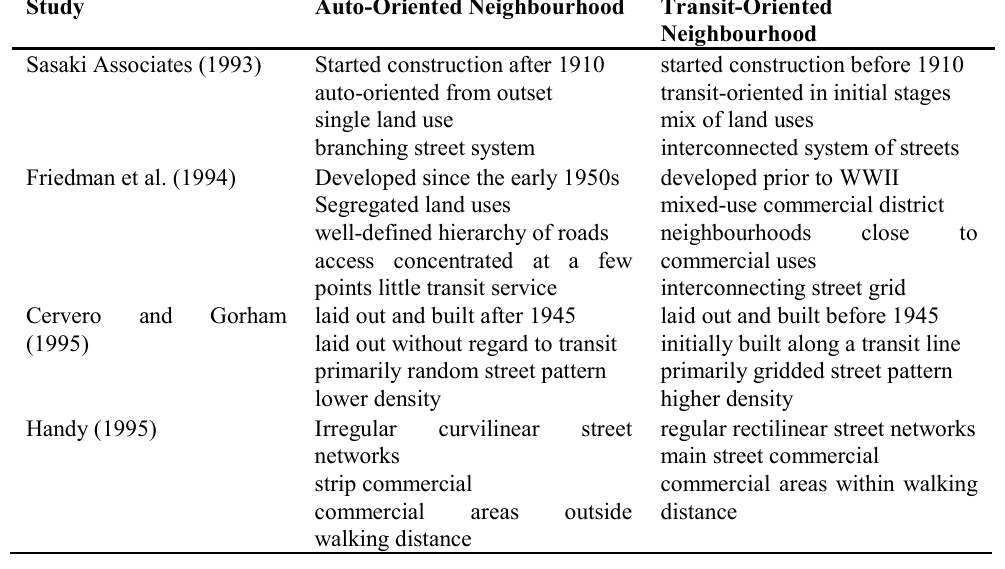
Table 1. Characteristics of Prototypical Neighbourhoods Study